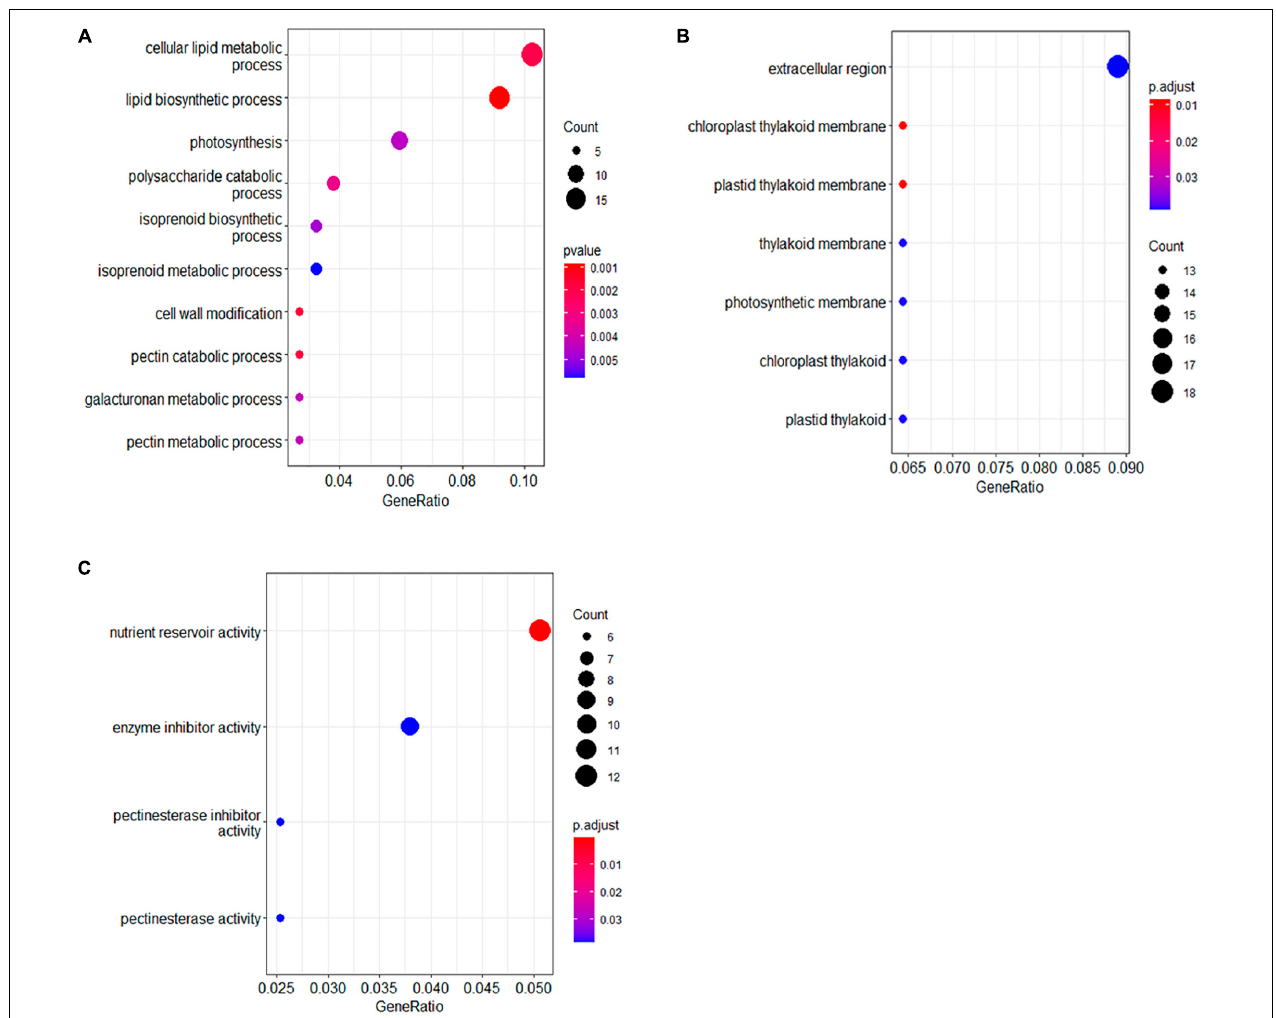
FIGURE 3 | Gene Ontology enrichment analysis for the differentially accumulated proteins between HOCL and LOCL. Gene Ontology enrichment analysis was categorized according to biology process [BP, (A) ], cellular component [CC, (B) ], and molecular function [MF, (C)